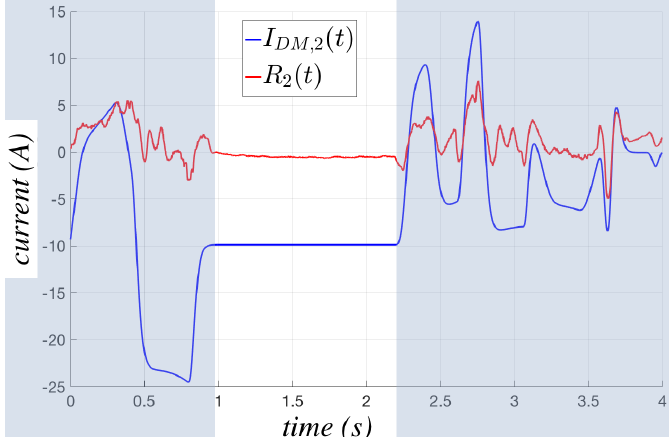
Figure 2. Behavior of the current residue of the second joint of an NJ4 110 in the steady (white background) and unsteady (blue background)